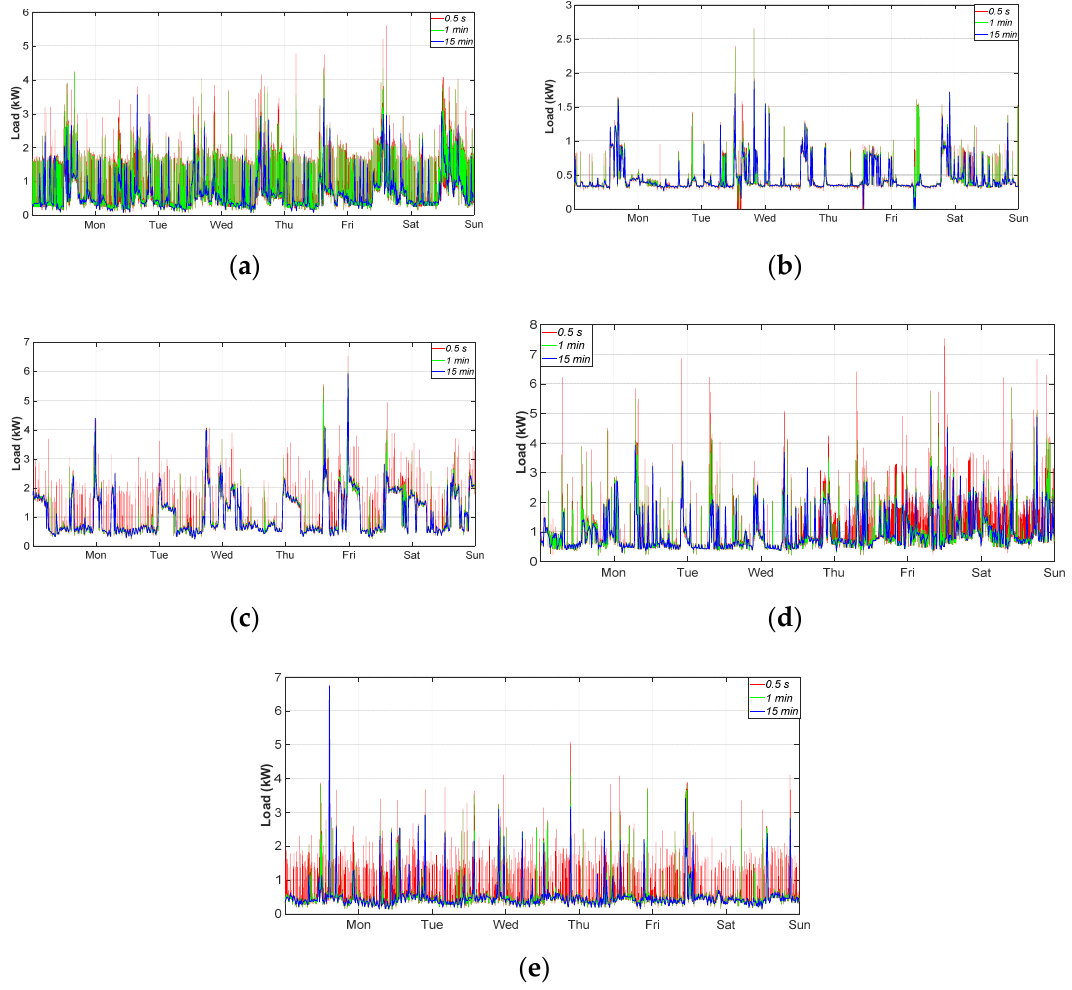
Figure 10. Weekly consumption profile: ( a ) Household #1, ( b ) Household #2, ( c ) Household #3, ( d ) Household #4 and ( e ) Household #5.